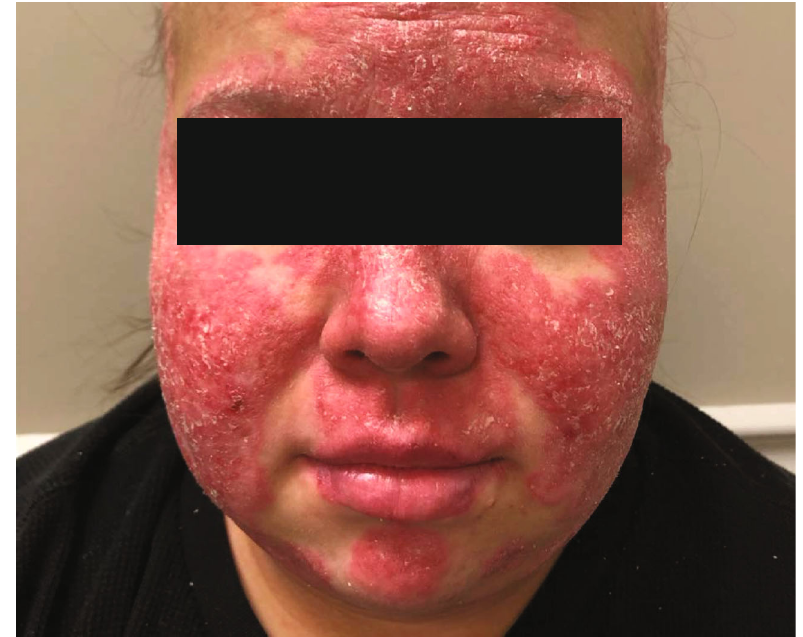
Figure 2: Acute cutaneous lupus erythematosus. Classic malar “ butter fl y ” rash of the forehead, chin, and malar cheeks. Note the relative sparing of the nasolabial